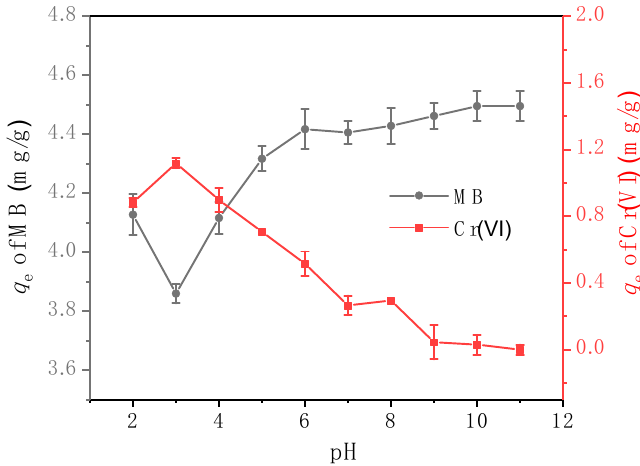
Figure 8. E ff ect of pH values on the adsorption of Cr(VI) and MB with CNBT: C 0Cr(VI) = 5 mg / L, Figure 8. Effect of pH values on the adsorption of Cr(VI) and MB with CNBT: C 0Cr(VI) = 5 mg/L, C 0MB = C 0MB = 20 mg / L, m / V = 2.5 g / L, T = 25 ◦ 20 mg/L, m/V = 2.5 g/L, T = 25 °C.